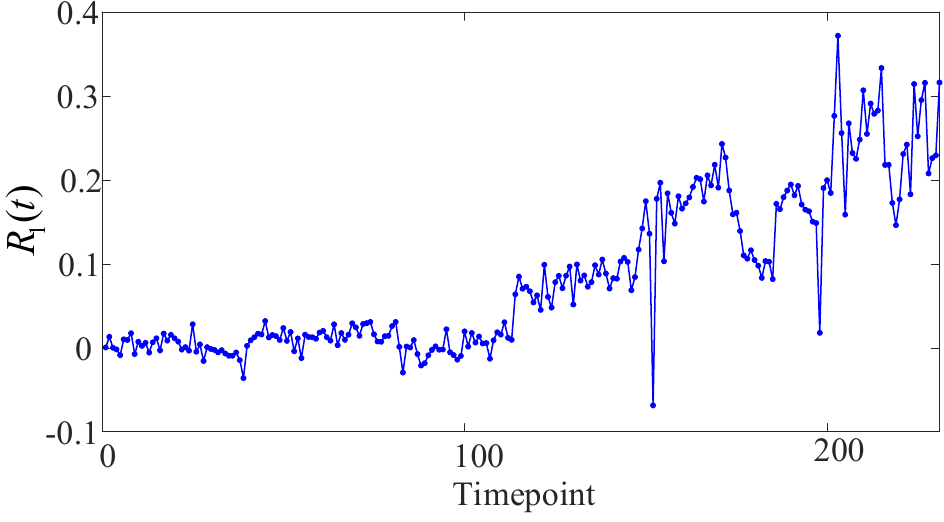
Figure 8. Unit time-domain degradation index sequence